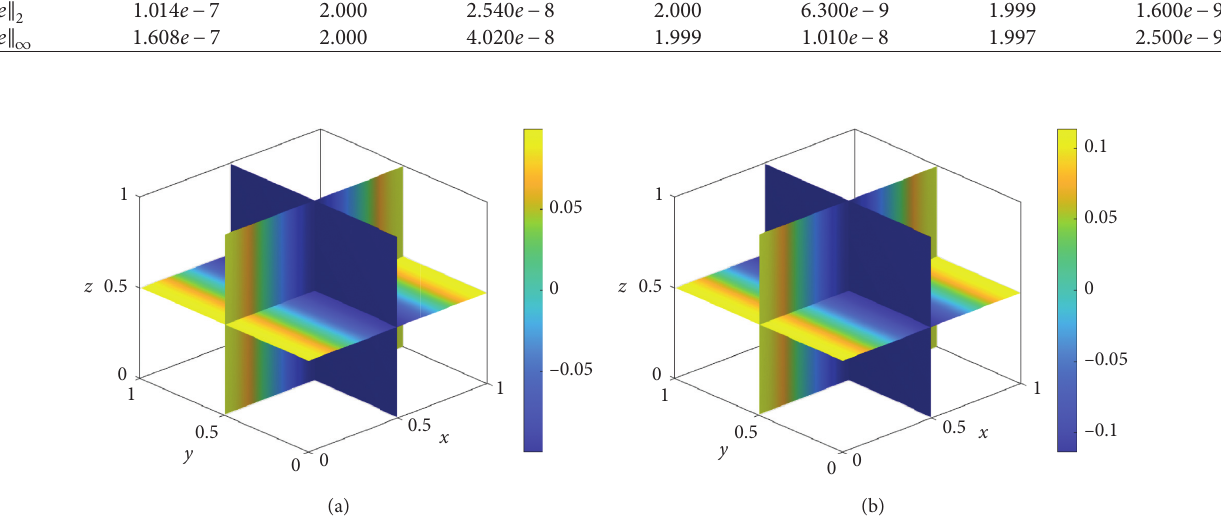
Table 6: Errors and convergence rates for the numerical results of the CN scheme at the final time T � 10 7 h 4 . Here, h � 1/128 is used. Δ t 10000 h 4